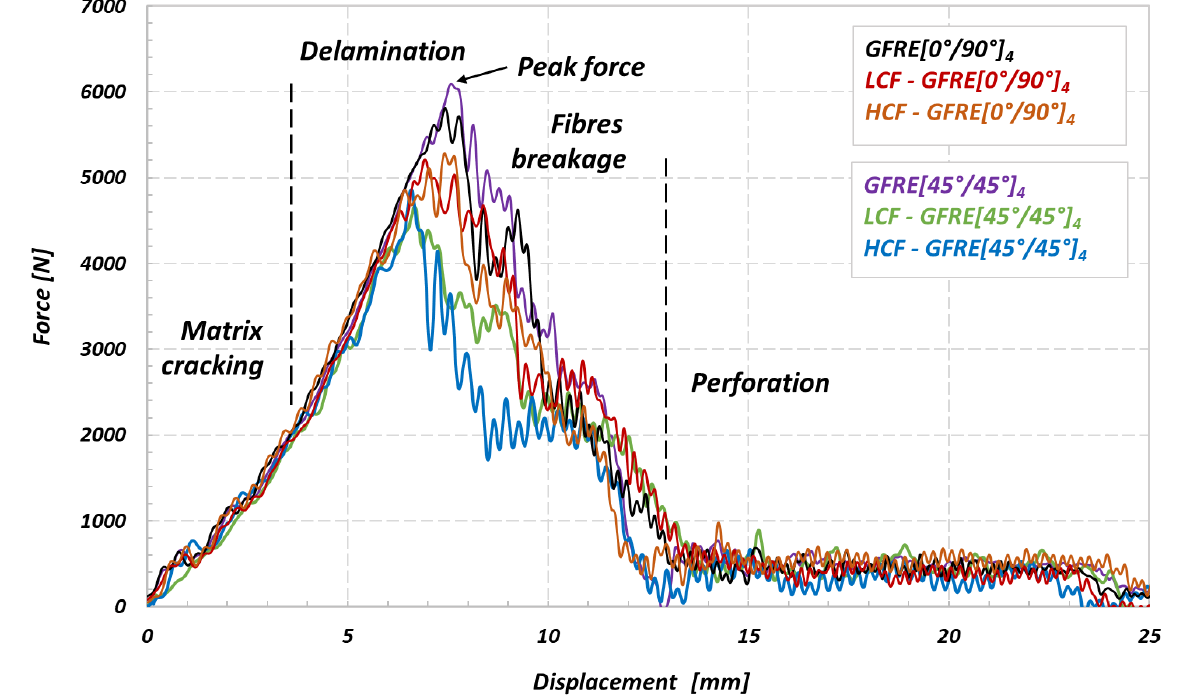
Figure 12. Force–displacement curves of the non-aged and aged GFRE [0 ◦ /90 ◦ ] 4 and GFRE [0 ◦ /90 ◦ ] 4 under different aging Figure 12. Force – displacement curves of the non-aged and aged GFRE [0°/90°] 4 and GFRE [0°/90°] 4 under different aging processes, the results are for impact energy of 50 processes, the results are for impact energy of 50 J.